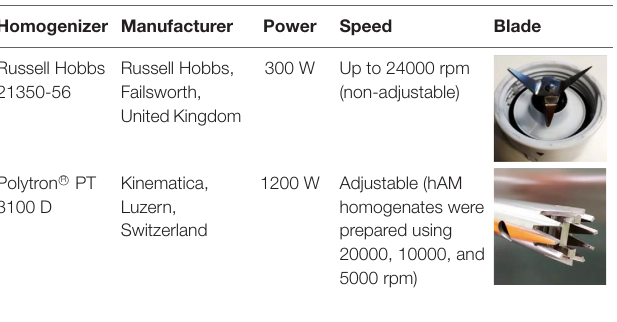
TABLE 1 | Specifications of homogenizers used for studying anticancer properties of hAM homogenate. Homogenizer